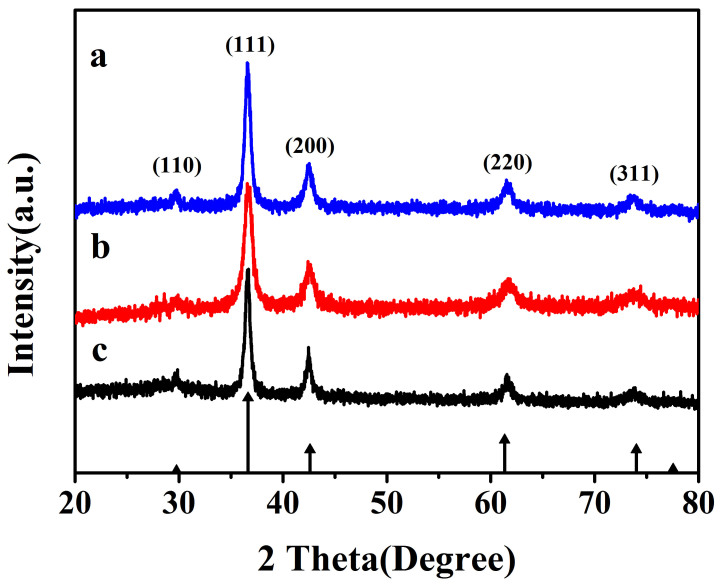
XRD patterns of the Cu2O prepared using different copper sources: (a) Cu(acac)2; (b) Cu(OH)2; (c) Cu(Ac)2·H2O.